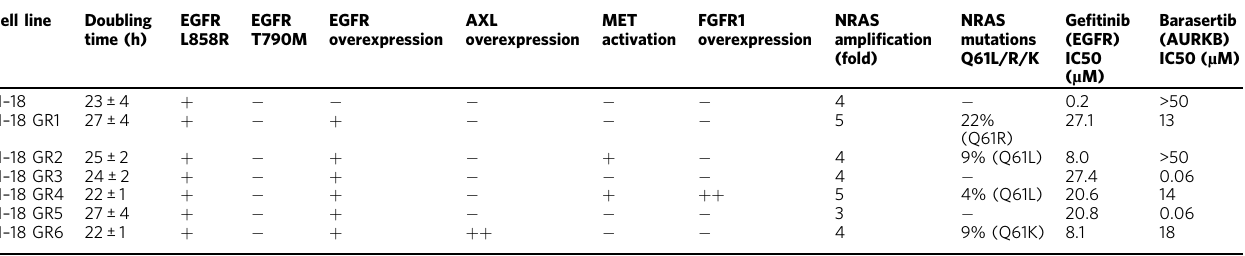
The targets of the drugs are indicated between parentheses. Doubling times are expressed as means±SD of at least three different